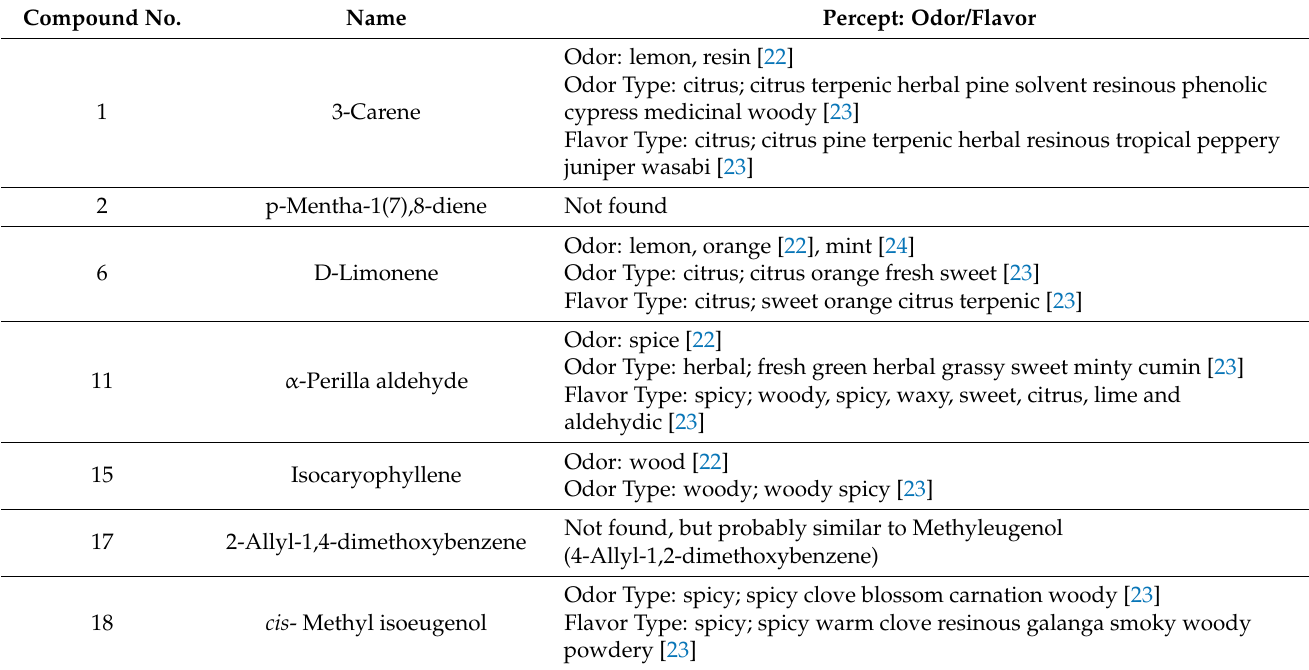
Table 5. Perception of the aromatic compounds of Chinese red basil. Compound No.